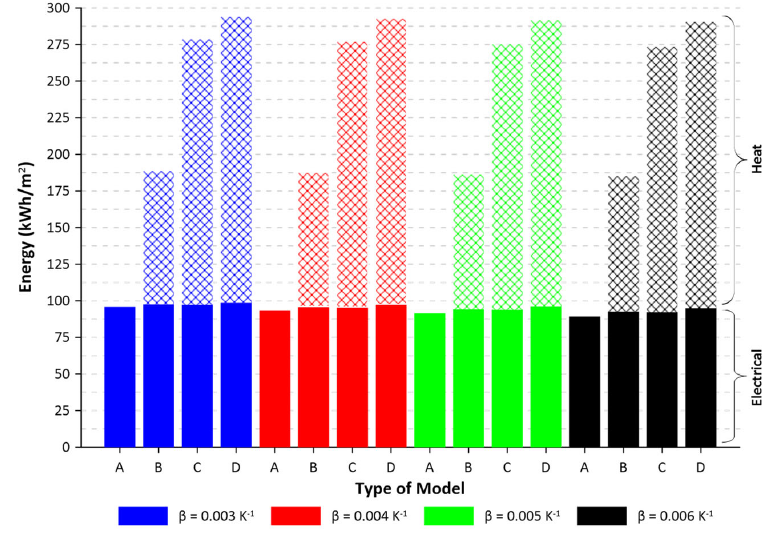
Figure 4. Electricity and heat production in analyzed models.